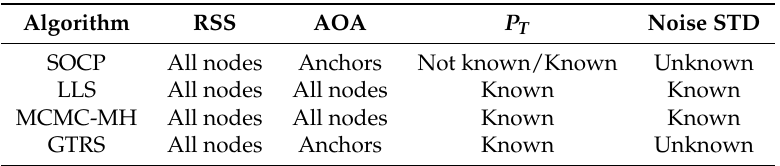
Table 1. Summary of the main characteristics of the considered algorithms. SOCP = second-order cone programming; LLS = linear least squares; MCMC-MH = Markov chain Monte Carlo with Metropolis-Hastings.